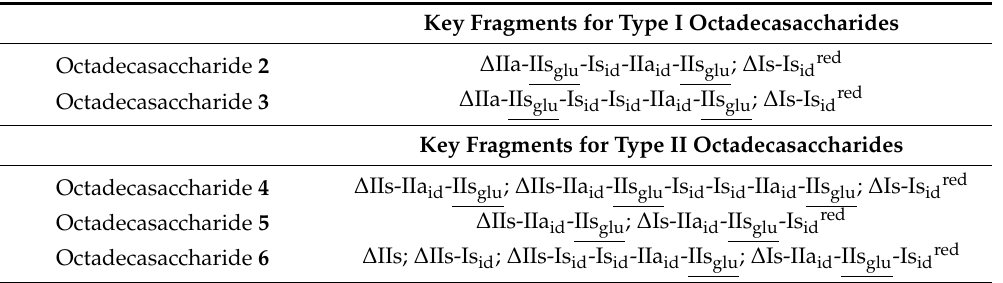
Table 3. Key fragments for octadecasaccharides. Key Fragments for Type I